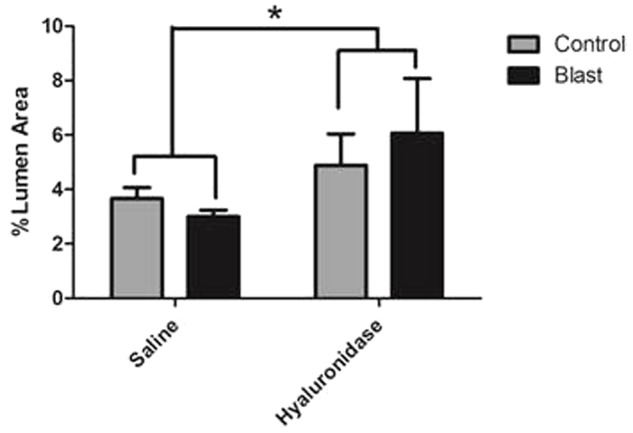
Hyaluronidase infusion significantly increased glycocalyx thickness in sham and blasted rats. Mean area of the glycocalyx quantified from the cerebral cortex of rats from each treatment group and expressed as a percentage of the total capillary lumen area (B). Capillaries from hyaluronidase infused rats showed a significant increase in percent lumen area of the glycocalyx in both sham exposed (HC, 4.886%) and blast exposed (HB, 6.067%) groups when compared to saline infused sham exposed (SC, 3.262%) and blast exposed (SB, 3.517%) groups. Asterisk denotes global significance between saline and hyaluronidase treatment groups (3.389% vs. 5.47%, Two-way ANOVA p = 0.0008).